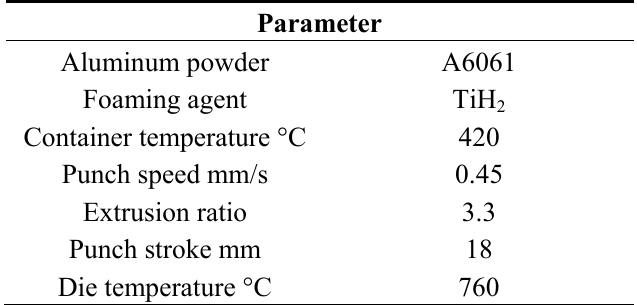
Table 2. Experimental condition for pipe molding of Al